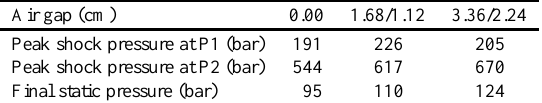
Table 3 The peak shock pressure and final static pressure in the cube cham- ber at different air gaps for a loading density of 9.80 kg/m 3 and water/explosive ratio of